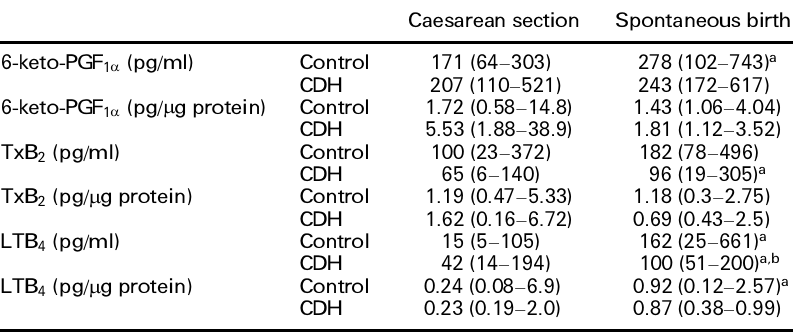
Table 2. Eicosanoids in BAL ¯ uid of controls and CDH pups after delivery by caesarean section or after spontaneous birth Caesarean section Spontaneous